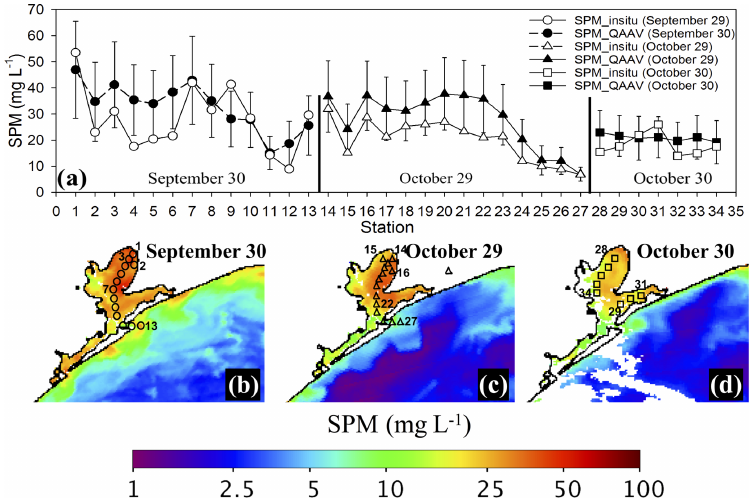
Figure 8. (a) Validation of QAA-V-derived SPM vs. in situ SPM for (b) 30 September 2017 (MRE = 39.9%, N = 13), (c) 29 October 2017 (MRE = 39.1%, N = 14), and (d) 30 October 2017 (MRE = 26.6%, N = 7). Stations for validation analysis (Fig. 8a) are also illustrated in corresponding SPM